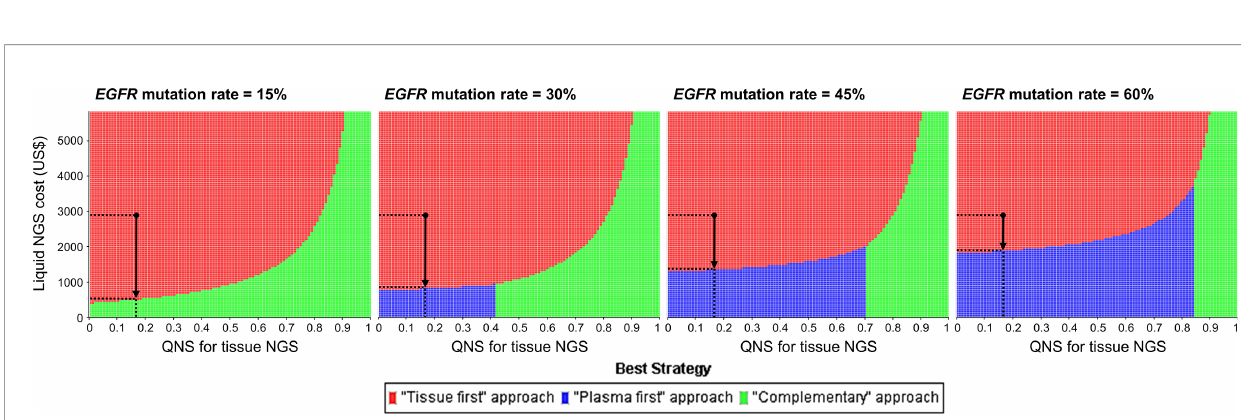
FIGURE 3 | Three-way sensitivity analysis for minimizing monetary loss. The black dots represent the baseline cost of liquid-based NGS and the probability that specimens are insuf fi cient for tissue-based NGS. In a population whose EGFR mutation rate was 15%, complimentary NGS approach would be preferable if the price of liquid-based NGS was reduced to US$526; and plasma- fi rst NGS approach would become preferable if its price in USD was reduced to $818, $1,343, and $1,869 given the EGFR mutation rate of 30%, 45%, and 60% respectively (vertical arrows). EGFR , epidermal growth factor receptor; NGS, next-generation sequencing; QNS, quantity not suf fi cient.